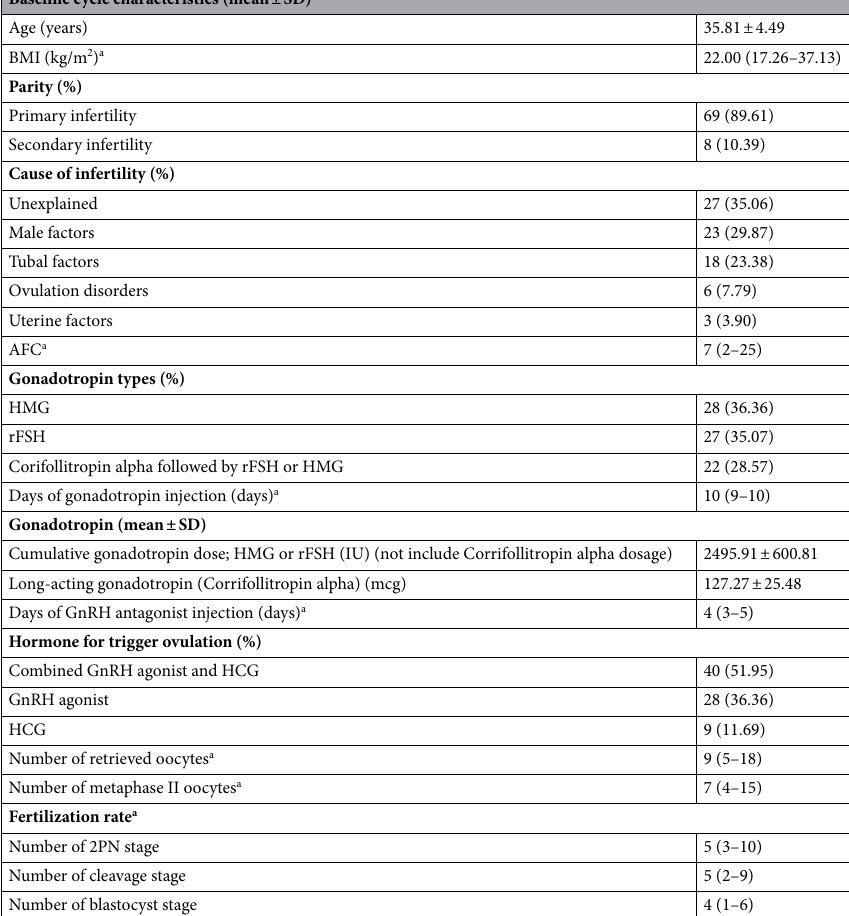
Table 1. Baseline characteristics. rFSH recombinant follicle stimulating hormone, HMG human menopausal gonadotrophin, HCG Human Chorionic Gonadotropin, GnRH Gonadotropin releasing hormone, PN pronuclei. a Data presented as median and interquartile range